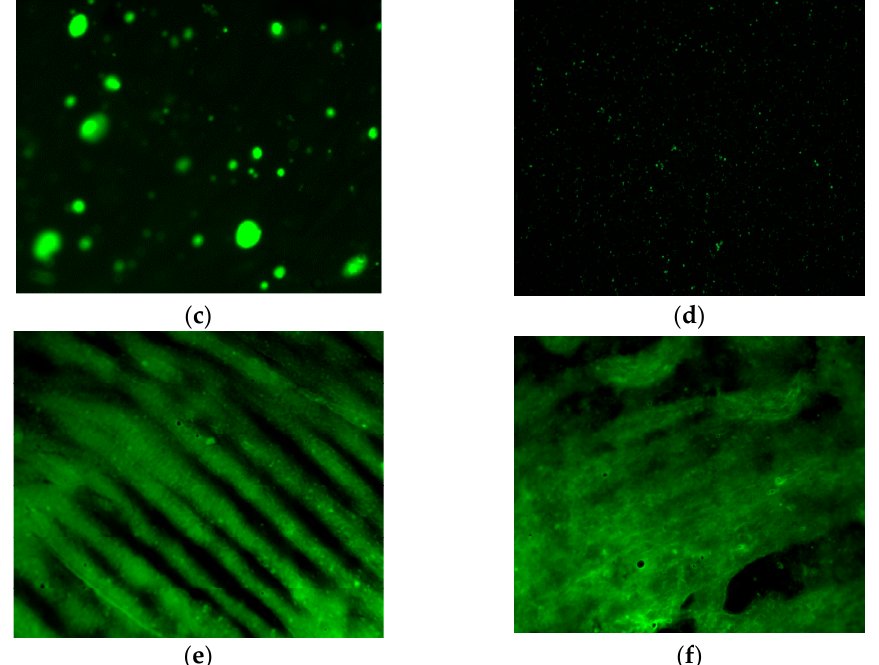
Figure 18. Fluorescence microscope (10 × 10) imagery. ( a – f ) represent matrix asphalt, 2% RPP modified asphalt, 5% RPP modified asphalt, 4% SBS modified asphalt, 2% RPP/4% SBS composite modified asphalt, and 5% RPP/4% SBS composite modified asphalt, respectively. The black area represents the asphalt phase, and the green area represents the polymer phase.